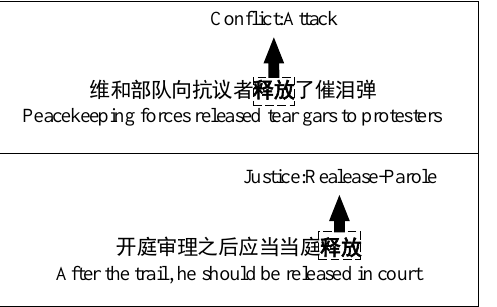
Figure 1. An example of polysemous trigger.